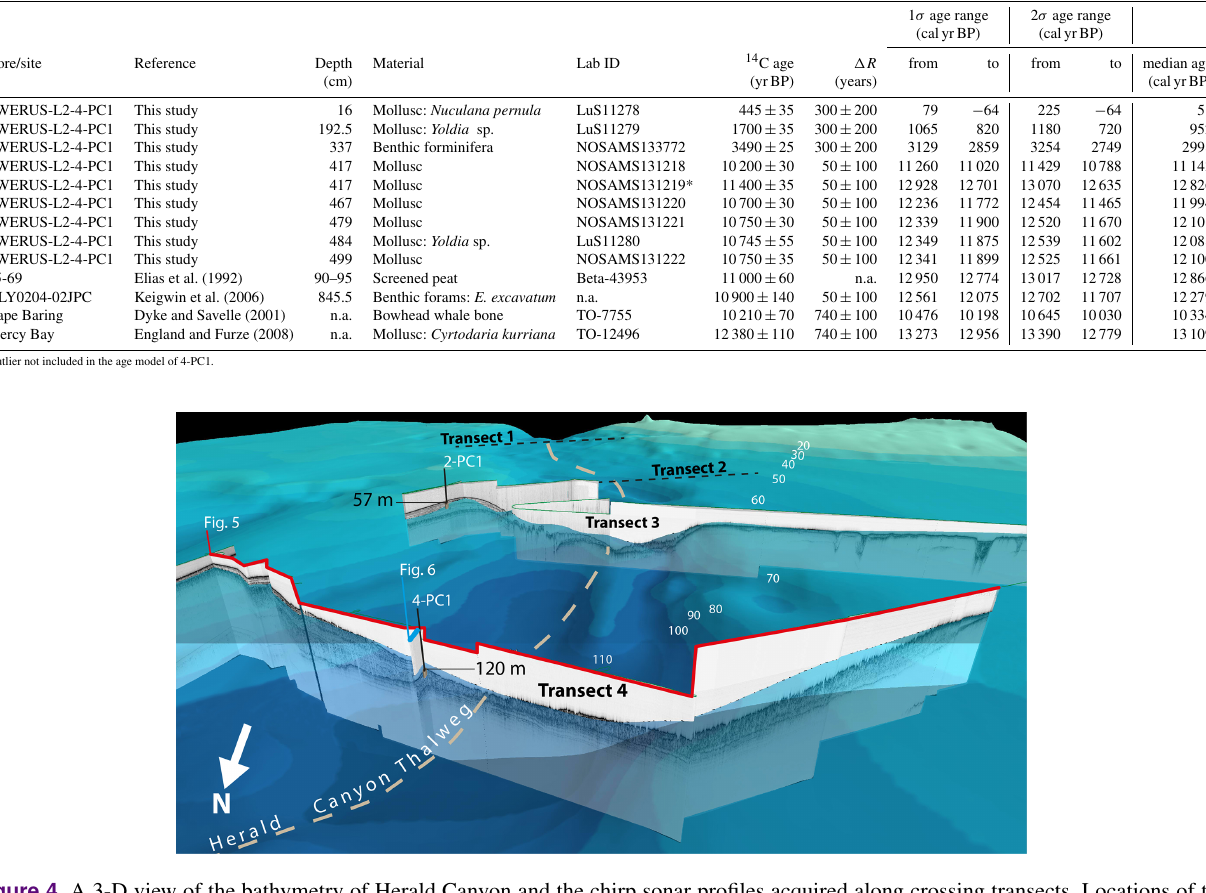
Figure 4. A 3-D view of the bathymetry of Herald Canyon and the chirp sonar profiles acquired along crossing transects. Locations of the coring sites are shown by black